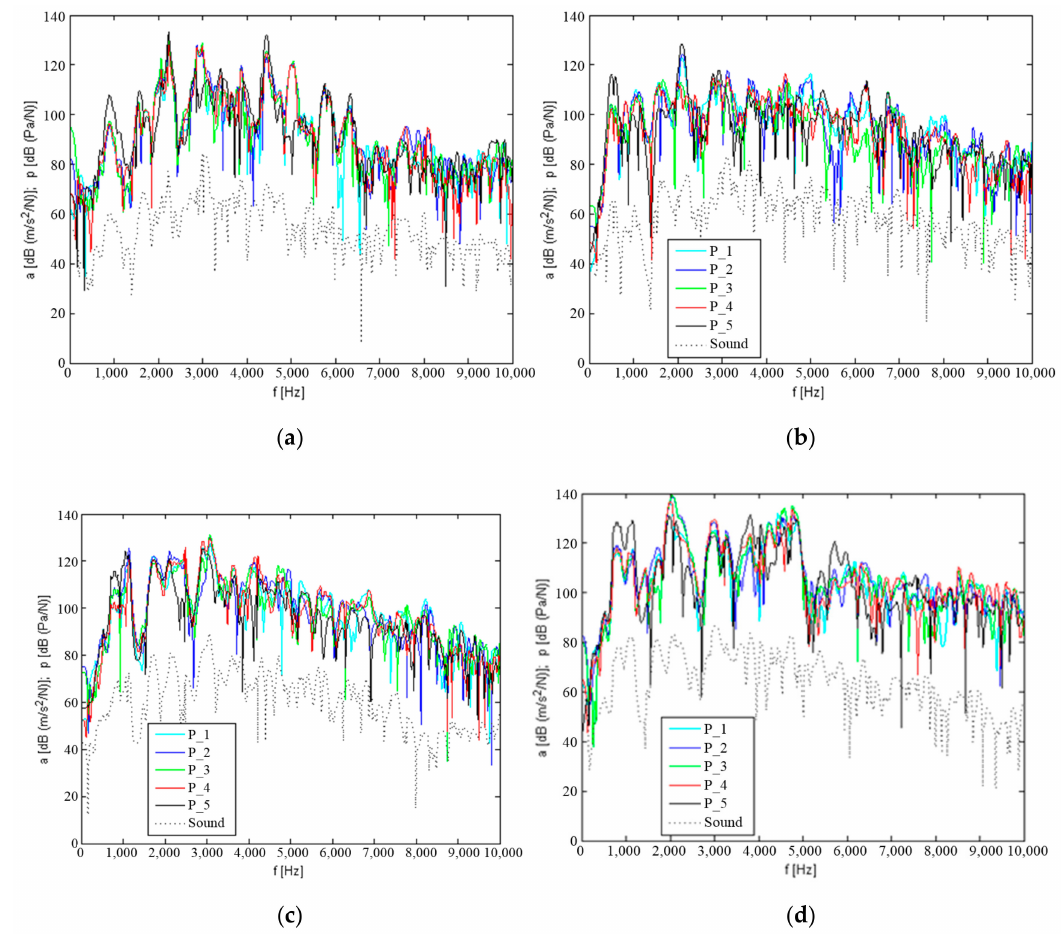
Figure 8. Natural and mutual transmittances of vibration response to impulse induction at point W2 and sound level above the housing: ( a ) Steel housing, ( b ) K_1 housing, ( c ) K_2 housing, and ( d ) K_3